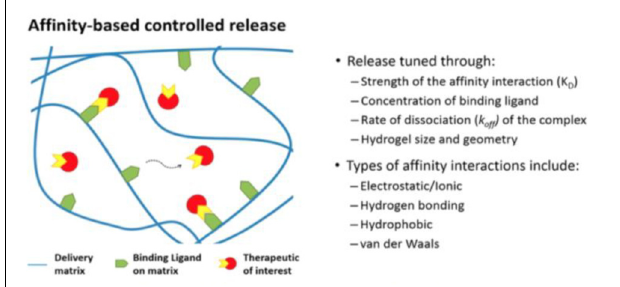
FIGURE 1 | Schematic of principles behind Affinity-Based Release Systems (Vulic and Shoichet, 2014) – Published under ACS Author Choice License, which permits copying and redistribution of the figure for non-commercial purposes.